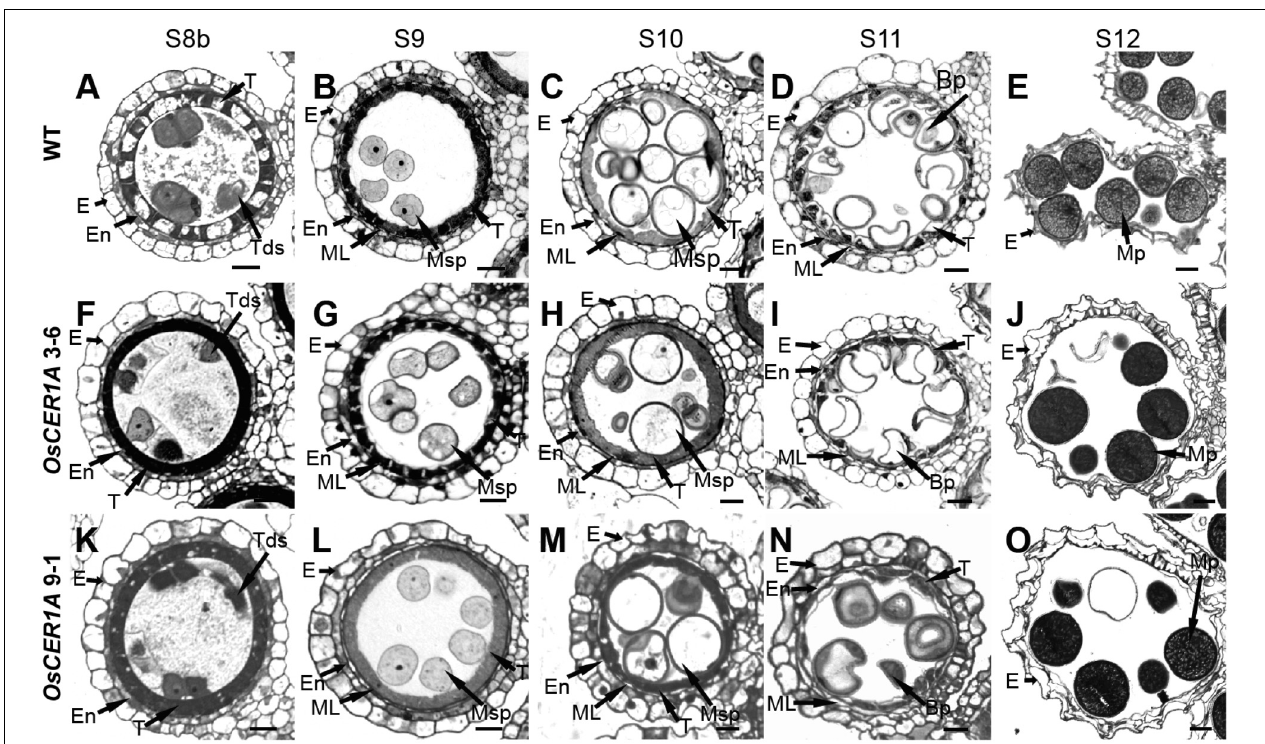
FIGURE 4 | Comparison of transverse semi-thin sections of anthers from the WT plants and OsCER1A lines. (A–E) Transverse semi-thin sections of a single locule of the WT anthers at stage 8b (S8b) (A) , stage 9 (S9) (B) , stage 10 (S10) (C) , stage 11 (S11) (D) , and stage 12 (S12) (E) . (F–J) Transverse semi-thin sections of a single locule of the OsCER1A 3-6 anthers at S8b (F) , S9 (G) , S10 (H) , S11 (I) , and S12 (J) . (K–O) Transverse semi-thin sections of a single locule of the OsCER1A 9-1 anthers at S8b (K) , S9 (L) , S10 (M) , S11 (N) , and S12 (O) . Bp, bicellular pollen; E, epidermis; En, endothecium; ML, middle layer; MP, mature pollen; Msp, microspore; T, tapetum; Tds, tetrads. Bars = 20 µ